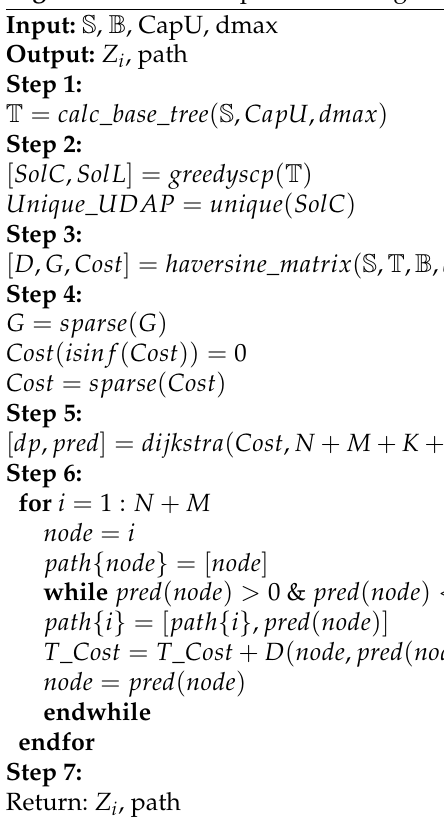
Algorithm 1 Main: Optimal Routing & Optimal # Z i